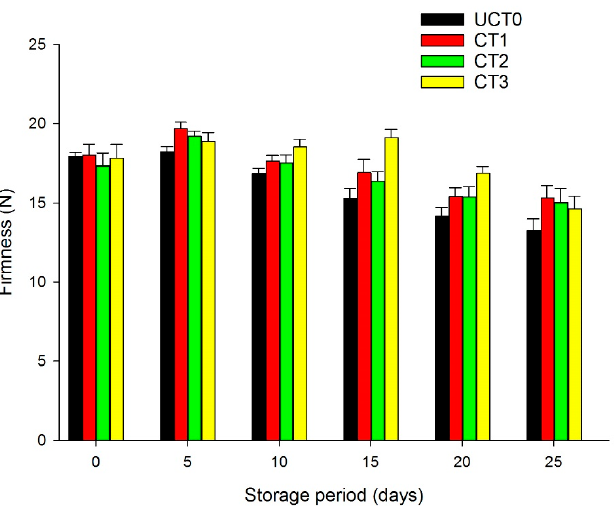
Figure 2. Firmness (N) of Golden Delicious apple slices coated (with CT1, CT2, and CT3), and not treated (UCT0) at day 0, and after 5, 10, 15, 20, and 25-days of storage at 4 °C in dark conditions and 85% relative humidity (RH). Values indicate the means ± standard deviations ( n = 3). Abbreviations: UCT0, uncoated apple slices used as control; CT1, apple slices coated with chitosan-glycerol-cinna- mon oil; CT2, apple slices coated with guar gum-glycerol-cinnamon oil; CT3, apple slices coated with composite guar gum-starch-glycerol-cinnamon oil.